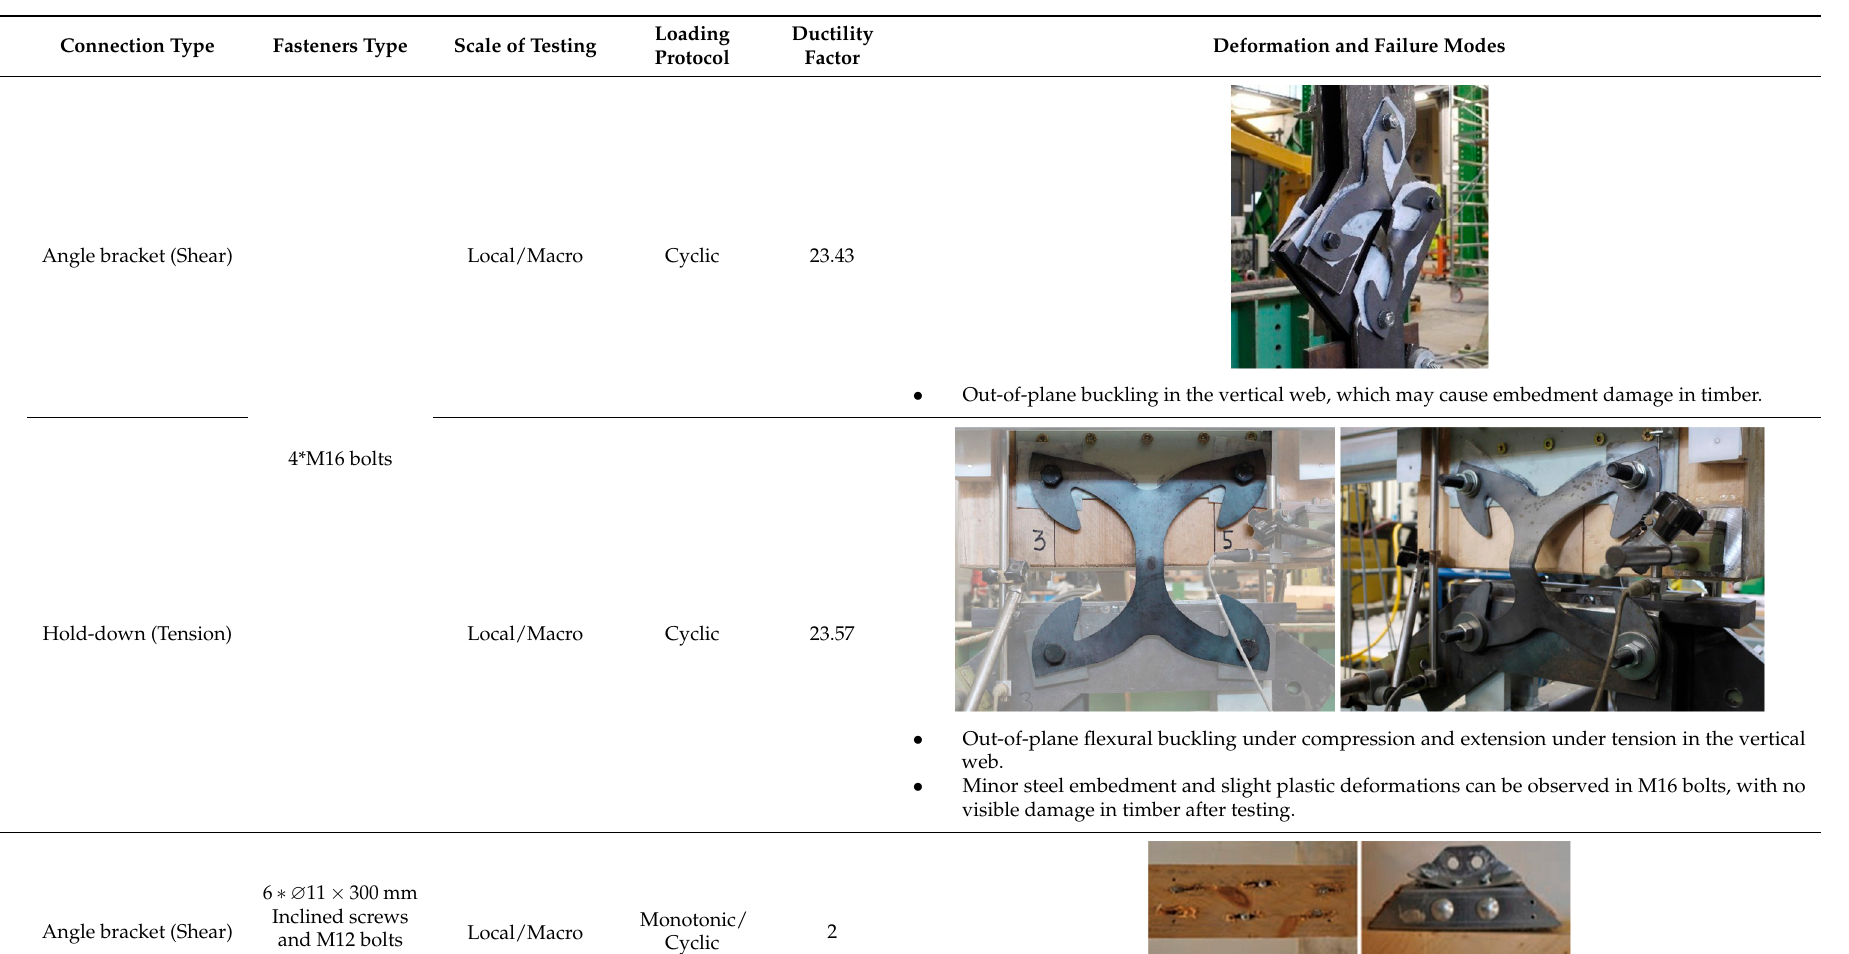
Table 2. Comparison of the experimental results for the novel connections.